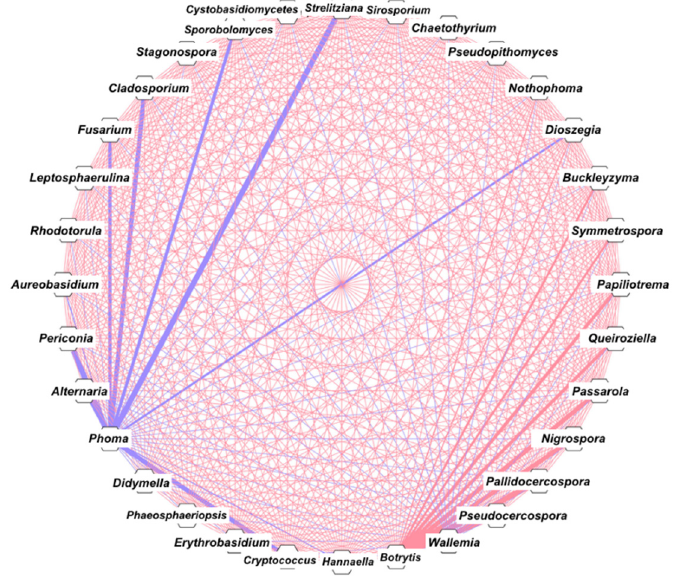
Figure 4. Network of mycobiome based on correlation analysis from taxonomic profiles. Each site corresponds to a genus. Cytoscape 3.7.1 was used for network construction. The thicker blue line represents strong negative interaction (Spearman’s rho < − 0.8) and the thicker red line represents strong positive interaction (Spearman’s rho > 0.8).